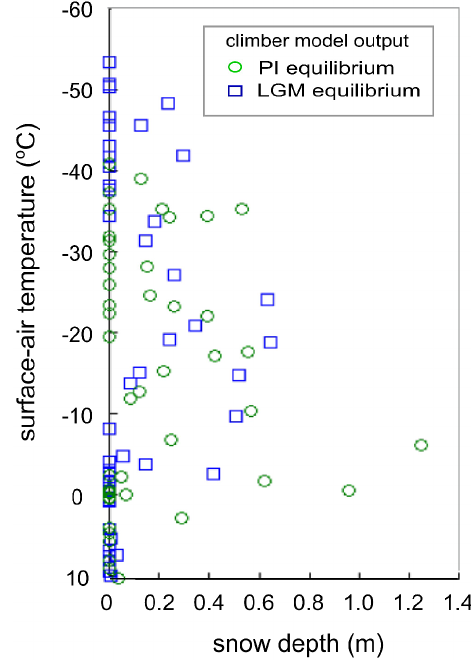
Figure B3. CLIMBER-2 model output for snow depth (m) plotted against surface air temperature ( ◦ C) for the PI(eq) (green circles) and LGM(eq) (blue squares) climates. Model output does not show extreme conditions for snow cover due to the very large grid-cell